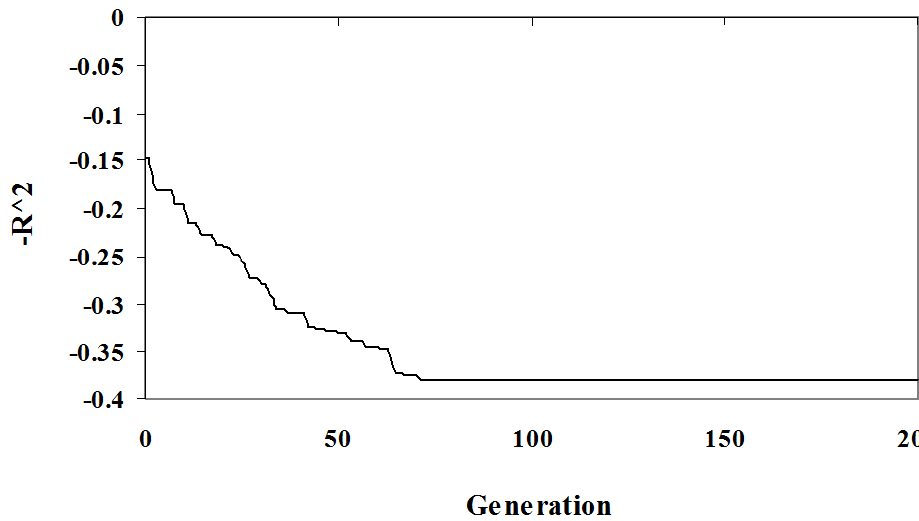
Figure 1. Algorithm Sample Run: The − R 2 value as a function of algorithm iteration of the best individual for an arbitrary